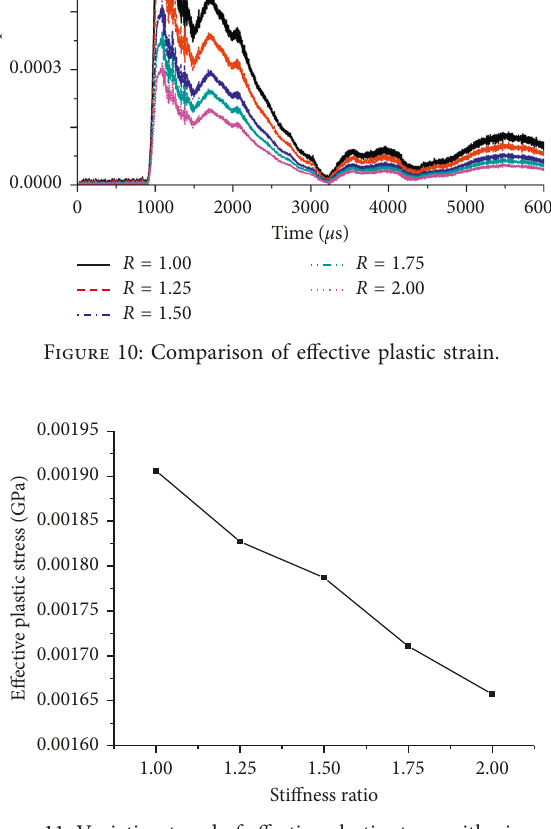
Figure 11: Variation trend of effective plastic stress with pipe-soil stiffness